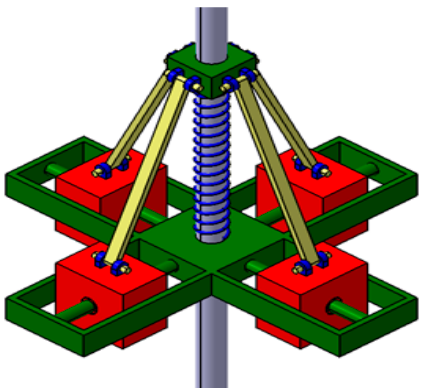
Figure 6. Variable inertial flywheel design.